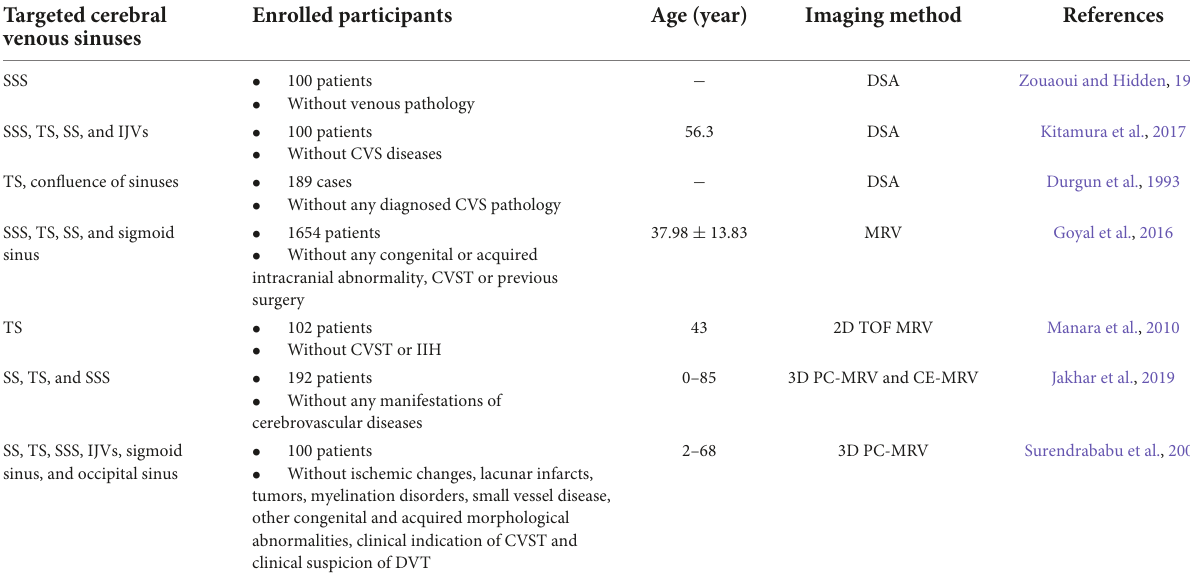
TABLE 1 Normal anatomy and variants of cerebral venous sinuses accessed by various imaging techniques.